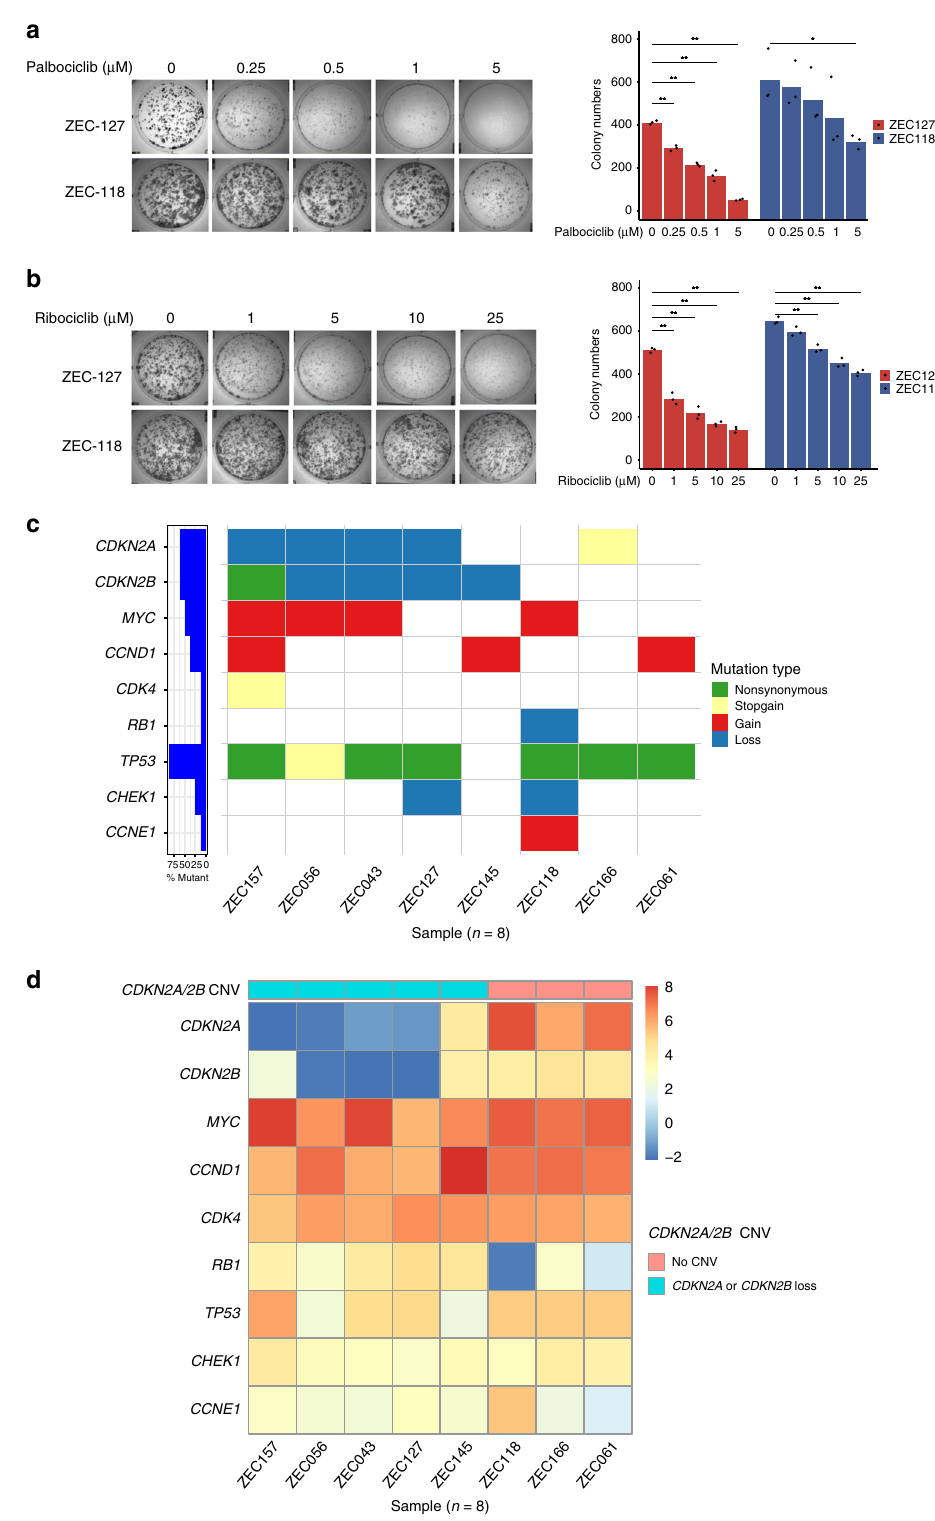
Fig. 4 Validation of the biomarkers of drug sensitivity in vitro. a , b ZEC127 ( CDKN2A / 2B loss) and ZEC118 ( CDKN2A / 2B no CNV) were used to evaluate the sensitivity of CDK4/6 inhibitors (palbociclib and ribociclib) using colony formation assays. Three experiments were averaged, and error bars correspond to the standard deviation of colony numbers. The colony number differences between different dose groups of inhibitors were compared using a Student ’ s t test and * p < 0.01 and ** p < 0.001. c Mutations of cell cycle checkpoint genes including CDKN2A , CDKN2B , MYC , CCND1 , CDK4 , RB1 , TP53 , CHEK1 , and CCNE1 were detected in eight ESCC PDCs using targeted deep sequencing. d Z -score analysis of the expression level of cell cycle checkpoint genes in the eight ESCC PDCs, which carried either CDKN2A or CDKN2B loss, or